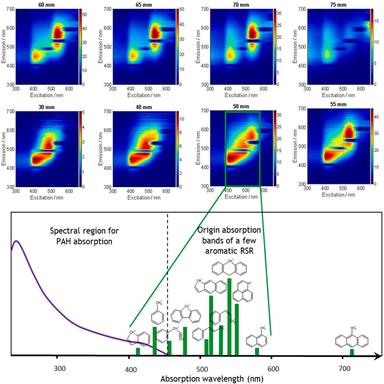
Evolution of the visible structures determined by the EEM fluorescence spectra in the neighboring of the inception along the central vertical axis of the flame. Typical PAH absorption bands (purple line). The green vertical lines correspond to the origin absorption bands of several aromatic RSRs (.